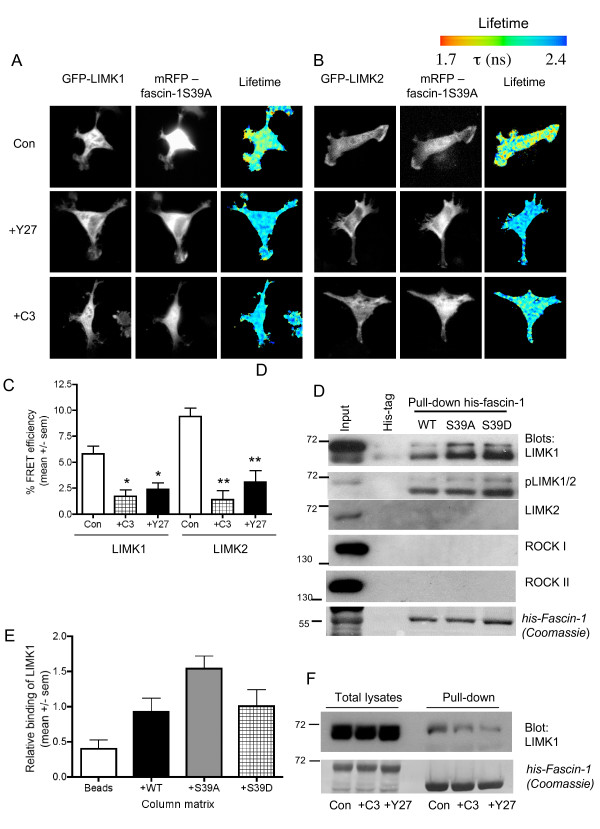
Rho-dependent and Rho kinase-dependent interaction of fascin-1 with p-Lin-11/Isl-1/Mec-3 kinase (LIMK) (A,B). Measurement of the interaction of (A) green fluorescent protein (GFP)-LIMK1 (A), or (B) GFP-LIMK2, with monomeric red fluorescent protein (mRFP)-fascin-1S39A in SW480 cells on laminin (LN). Cells transiently transfected with the indicated plasmids were plated on LN for 2 hours, without or with pre-treatment with the indicated inhibitors, then fixed, mounted, and imaged using fluorescence lifetime imaging microscopy (FLIM) to measure fluorescence resonance energy transfer (FRET). In each panel, intensity multiphoton GFP (donor) images are shown with the corresponding epifluorescence image for monomeric red fluorescent protein (mRFP) (acceptor). Lifetime images are presented in a blue-to-red pseudocolor scale with red as short lifetime. (C), Percentage FRET efficiency under each experimental condition. Each column represents the mean from nine to sixteen cells per condition and three independent experiments; bars indicate SEM. *P < 0.01 versus control; **P < 0.005 versus control. (D) Representative immunoblots from pull-downs of SW480 cell lysates with hexahistidine (6His)-tagged fascin-1 (wild-type (WT), S39A or S39D) bound to nickel-agarose beads. (E) Quantification of LIMK1 binding to fascin-1 bead matrices. For each matrix, LIMK1 binding was ratioed to binding to the bead-only matrix, based on quantification of grayscale images in ImageJ software (http://rsb.info.nih.gov/ij/download.html). Each column represents mean values from three independent experiments; bars indicate SEM. (F) Demonstration that LIMK1 binding to 6His-fascin-1 depends on Rho and Rho kinase activities. Representative of three independent experiments. (D,F) Molecular markers are in kDa.